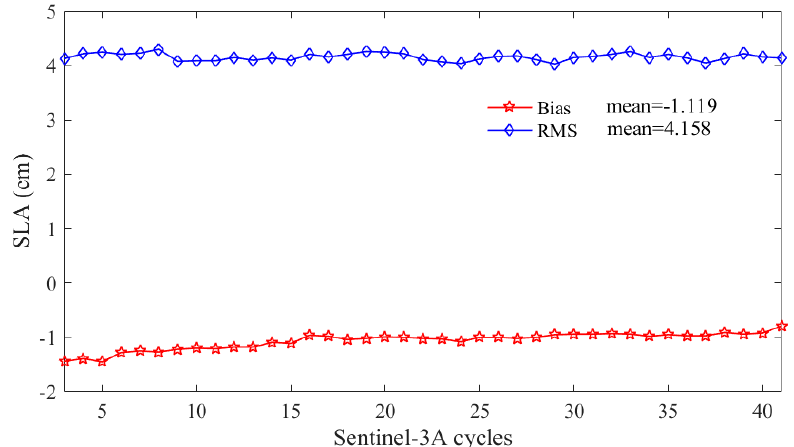
Figure 17. Cycle by cycle biases and standard deviations of SLA differences between SAR and PLRM mode.